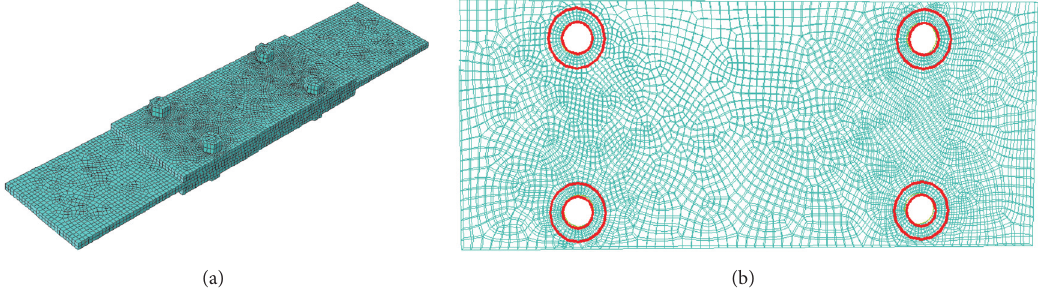
Figure 16: Finite element model: (a) global model; (b) local